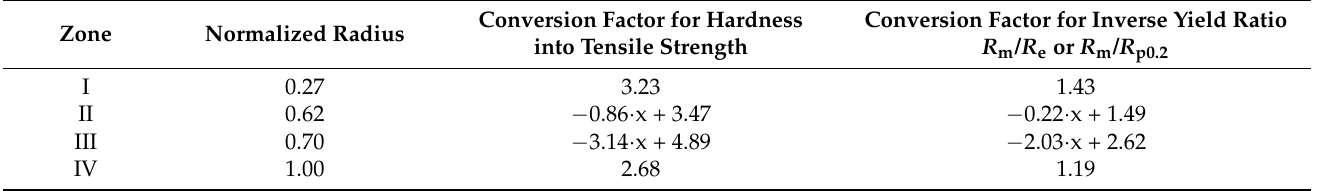
Table 6. Conversion factors for all defined zones over the rebar